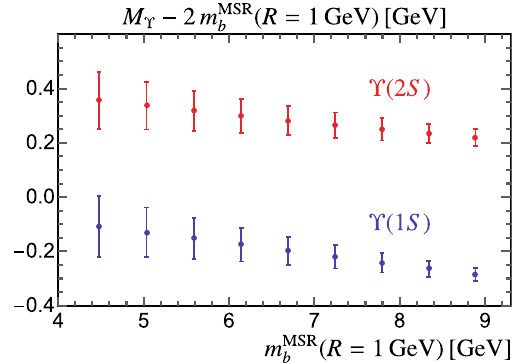
Fig. 9 Dependence of the Υ ( 1 S ) (blue) and Υ ( 2 S ) masses with the bottom mass. We subtract from the hadron masses twice the MSR bot- tom mass at the scale R =